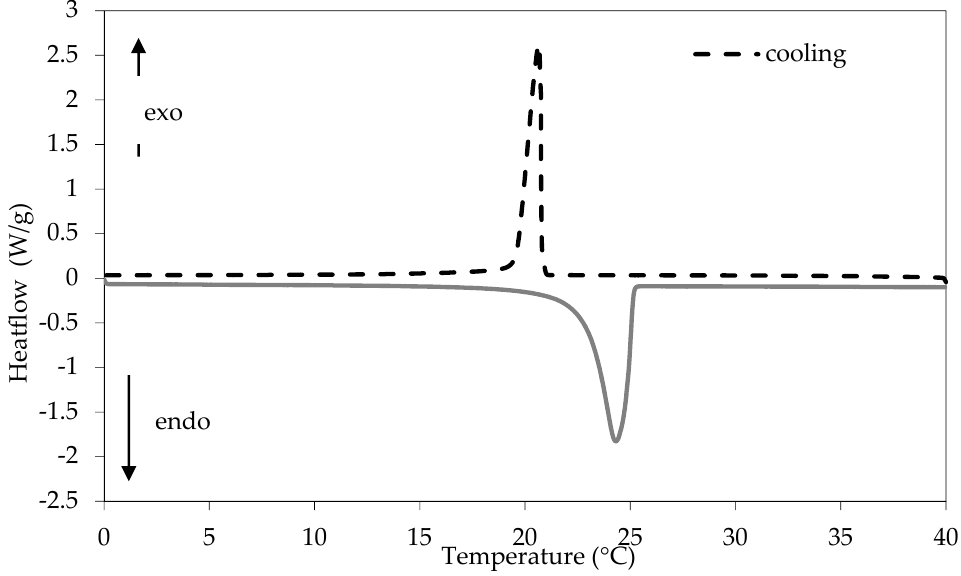
Figure 1. Phase change intervals of diatomite/dodecanol PCM composite [38].